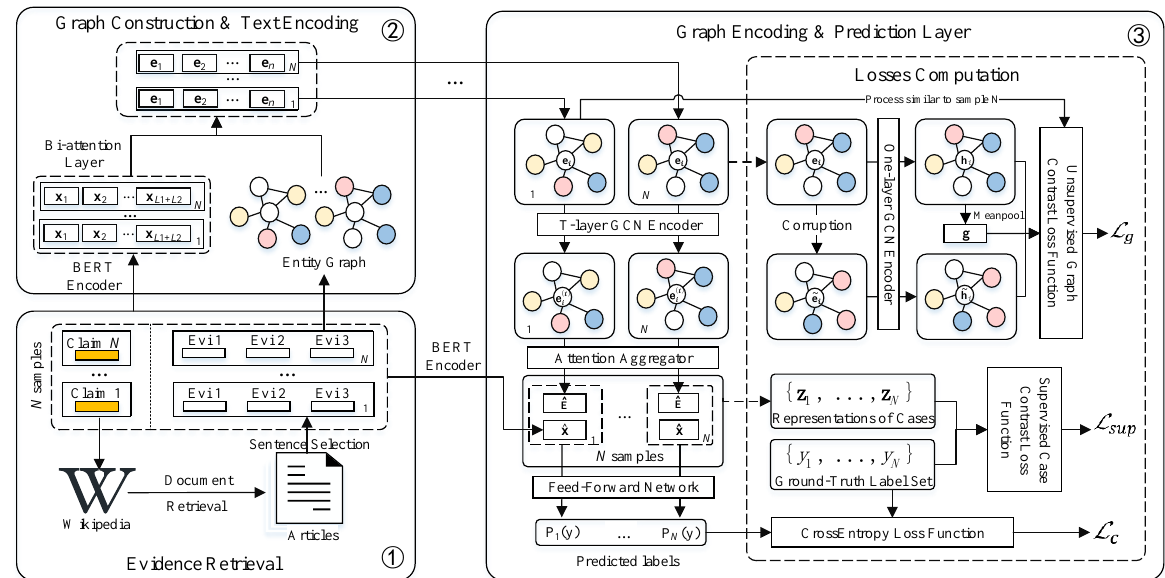
Figure 3. Detailed structure of the CosG